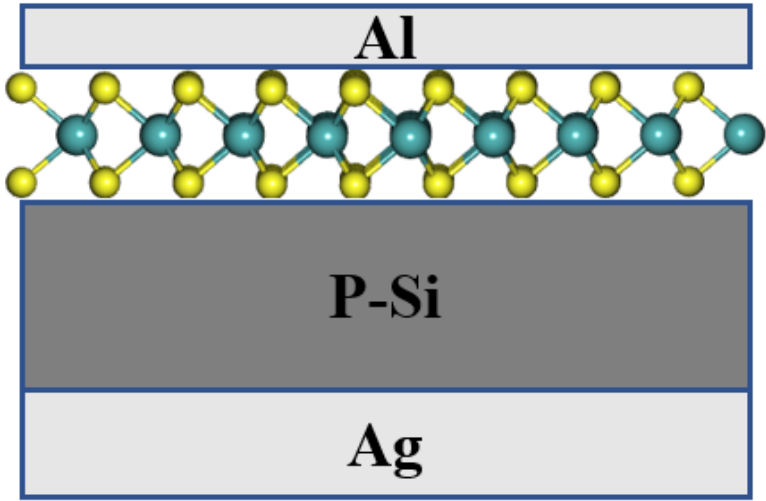
Figure 7. Simulated solar cell structure of solar cell.